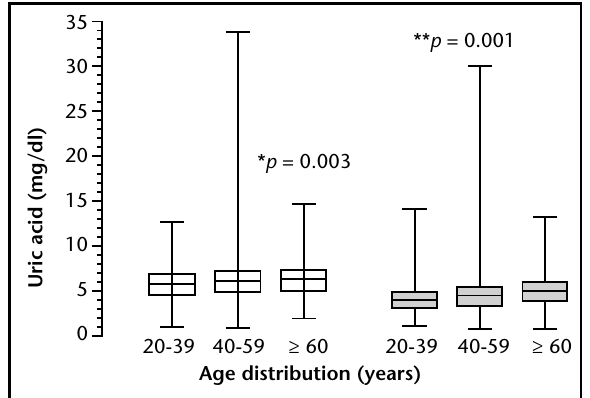
Figure 2 – Median (interquartile range) of serum uric acid in men (left clear boxes) and women (right dark boxes) according to age distribution * p -value for the comparison between groups of men with the three different age ranges, and ** p -value for the comparison between groups of women with the three different age ranges (Kuskal-Wallis test). Each pair-wised comparison between the groups with the different age ranges, for both men and women, showed a p < 0.001; by the post-hoc Dunn’s multiple comparison test. Comparisons between the groups of men and women for each age range showed a p < 0.0001; (Mann-Whitney test).